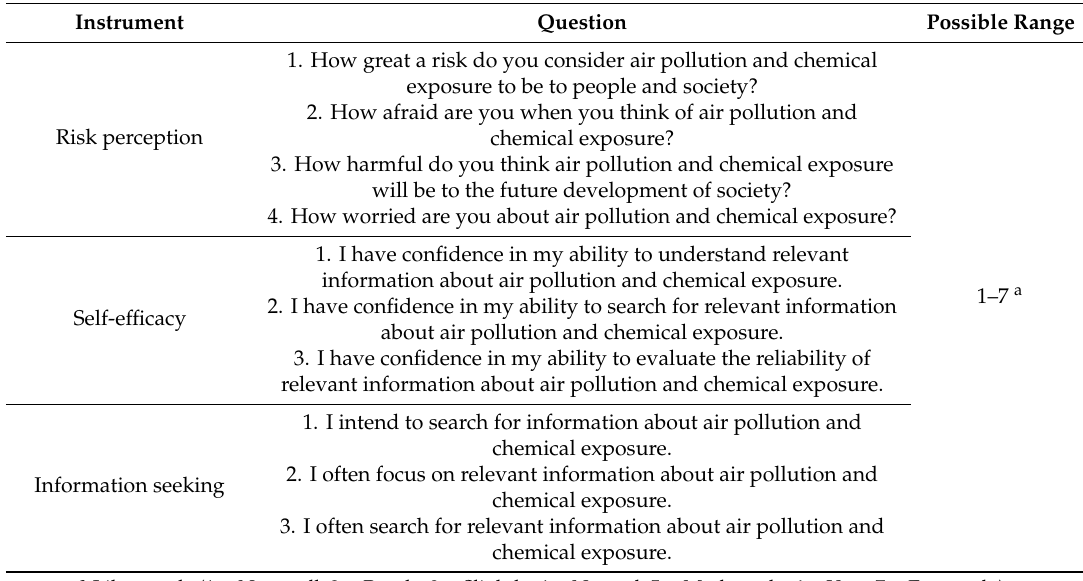
Table 1. Questionnaire measuring behaviors related to air pollution and chemical